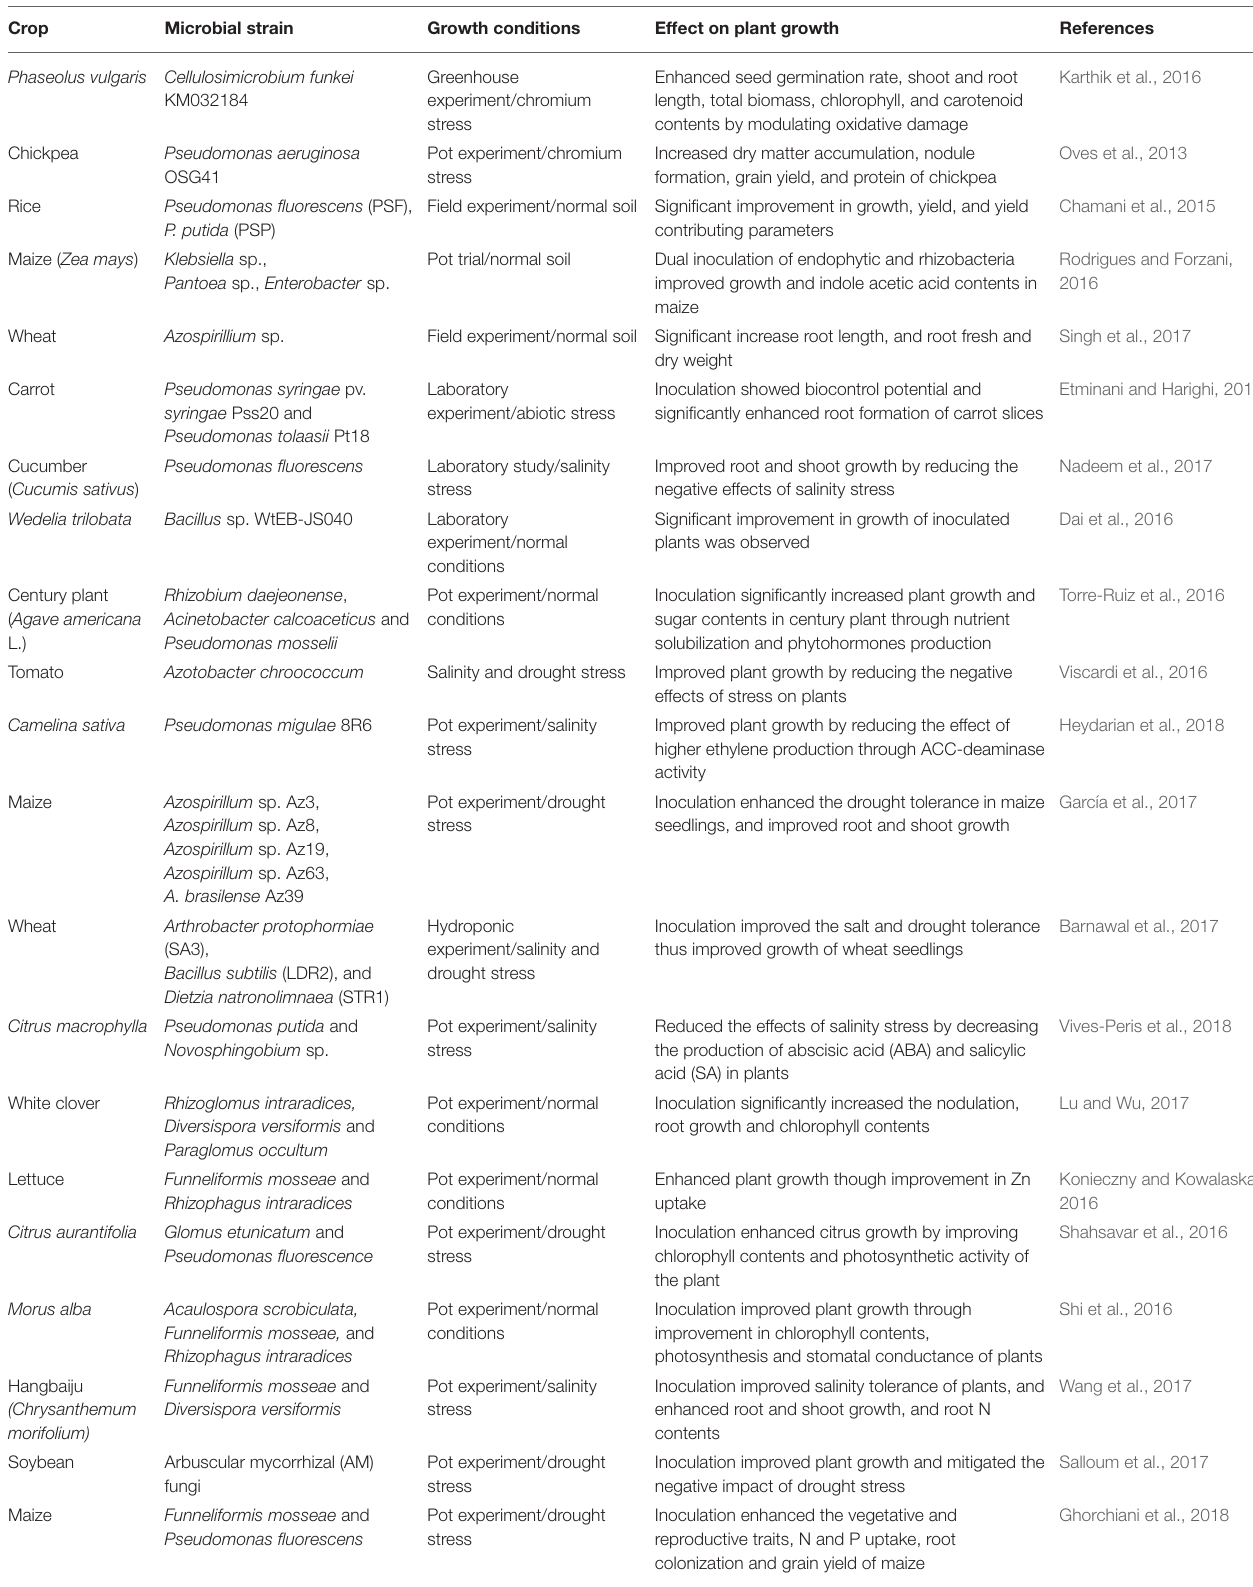
TABLE 1 | Effect of inoculation with soil microorganisms on plant growth.